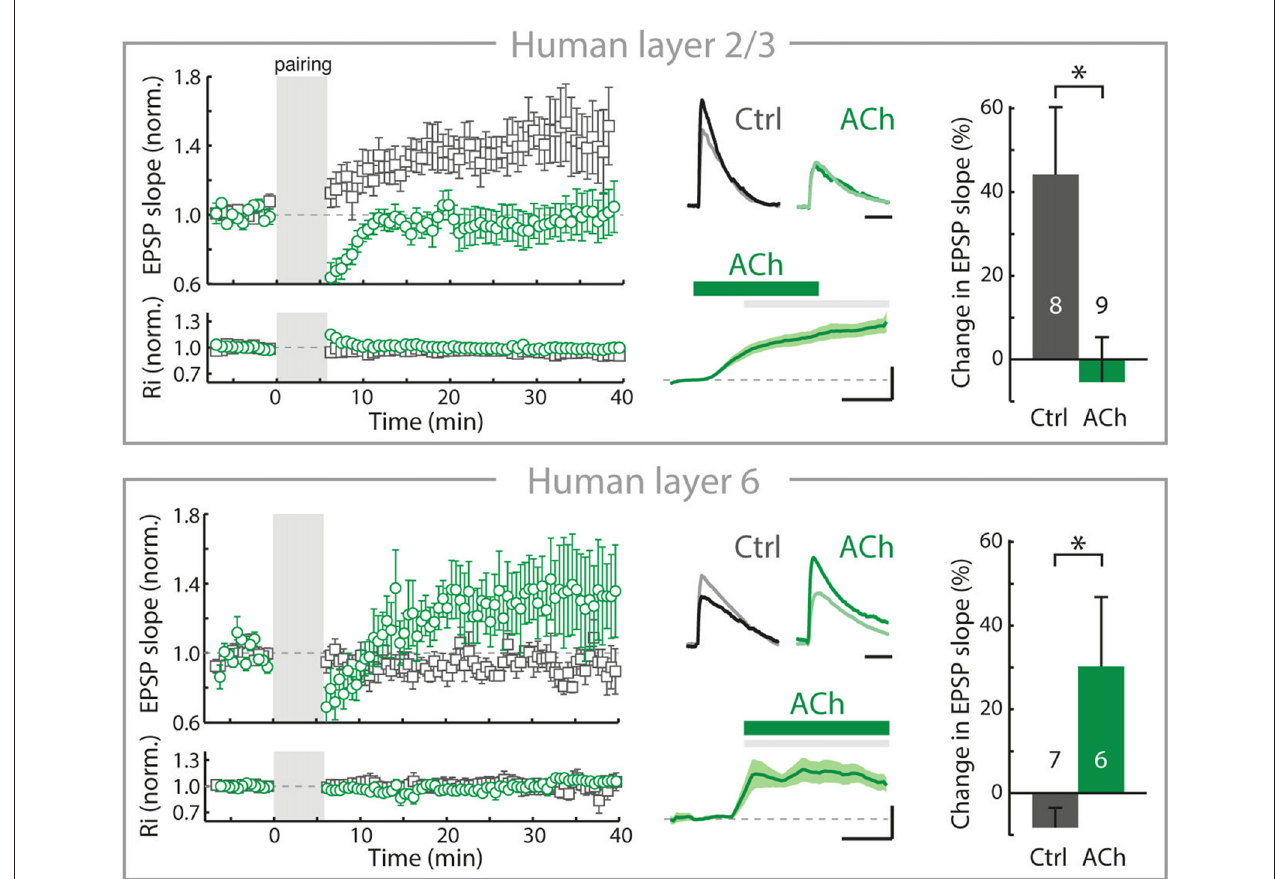
FIGURE 2 | In adult human neocortex, ACh alters long-term synaptic plasticity of glutamatergic synapses in opposite directions in superficial and deep layers. Top, left: In adult human neocortical L2/3 pyramidal neurons in control conditions (open gray square) and experiments where ACh was present in the bath during long-term potentiation induction (pre- and postsynaptic activity pairing, open green circle). Top, middle: top traces: example EPSP waveforms recorded during baseline (light color) and 20–25 min. after pairing (dark color), for tLTP experiments with and without ACh present in bath during pairing. Horizontal scale bar: 30 ms; vertical scaling as below. Bottom traces: membrane potential change over course of pairing period (gray shading) relative to baseline for experiments where ACh was washed-in during pairing. Scale bars, 3 mV, 2 min. Top, right: summary bar chart showing change in EPSP slope of control LTP and ACh LTP experiments in human L2/3 neurons. Bottom, as in top figure, for nAChR-bearing human L6 pyramidal neurons. Note that in contrast to L2/3, in L6 long-term potentiation of human glutamatergic synpases is increased by ACh ( ∗ p ≤ 0.05). Figure is modified from Verhoog et al. (2016), no permission